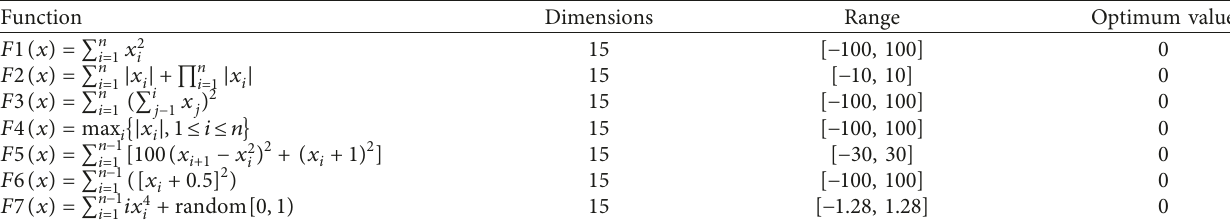
Table 1: Unimodal benchmark functions.